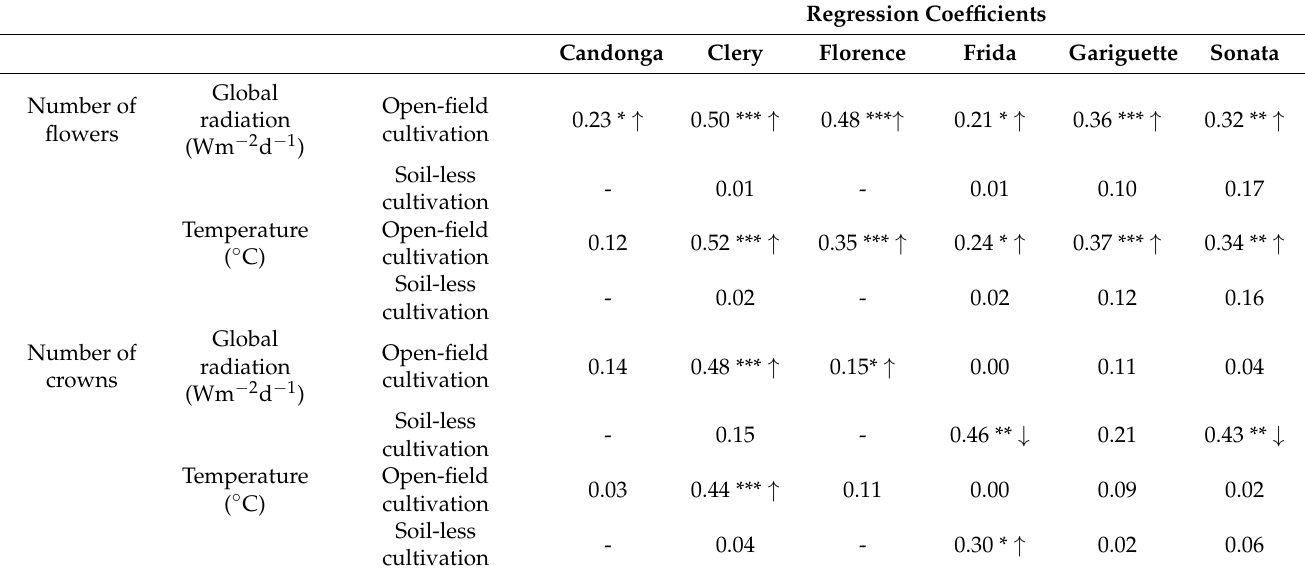
Table 5. Regression coefficients (R 2 ) for six strawberry cultivars for their number of flowers and crowns related to global radiation and temperature during the 3-week period preceding flower initiation when grown at five locations in